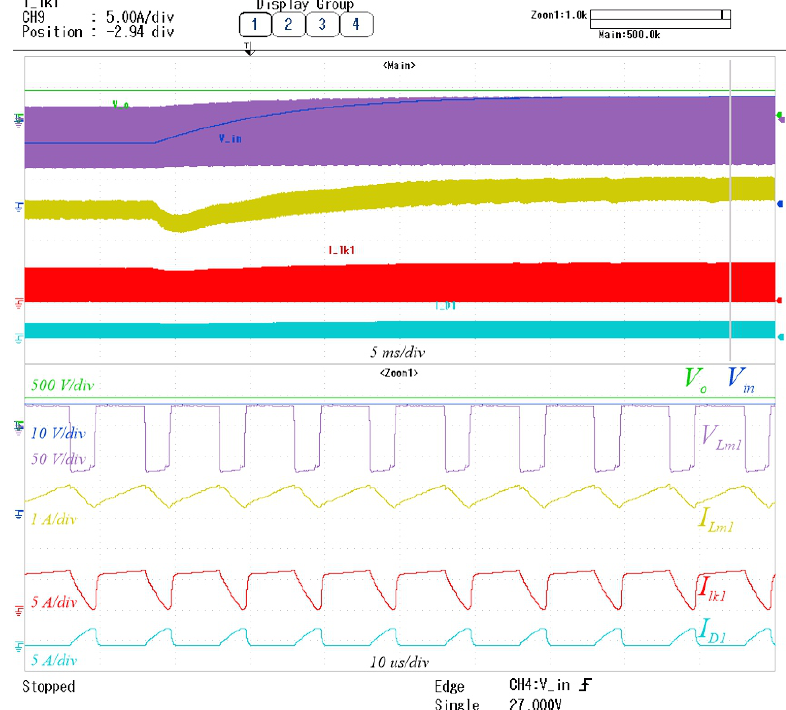
Figure 10. Dynamic response of the main waveforms of the SICIBB converter for a step change from 20V to 35V at 8